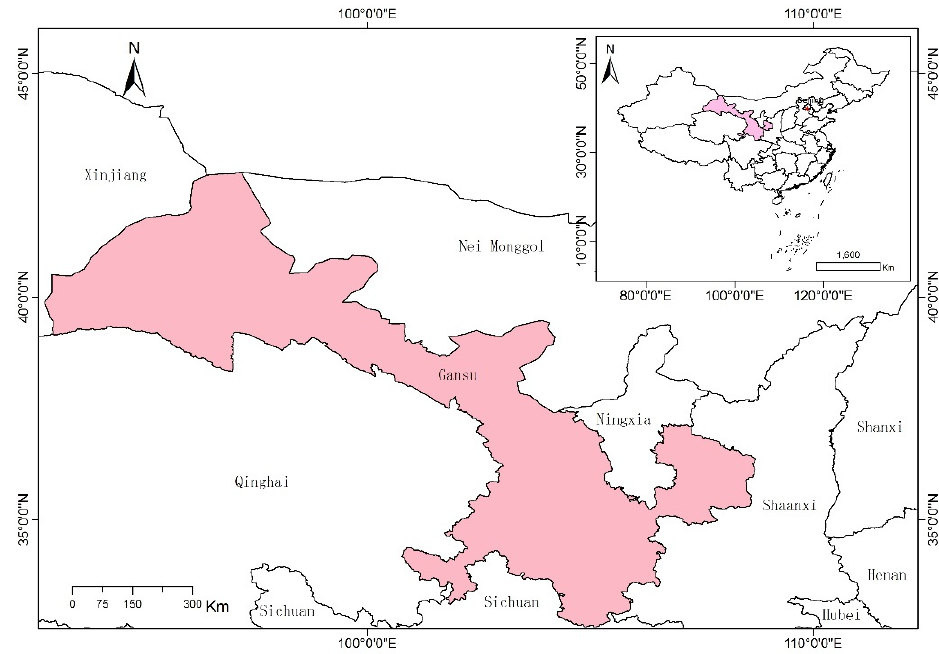
Figure 1. Schematic of the study area.